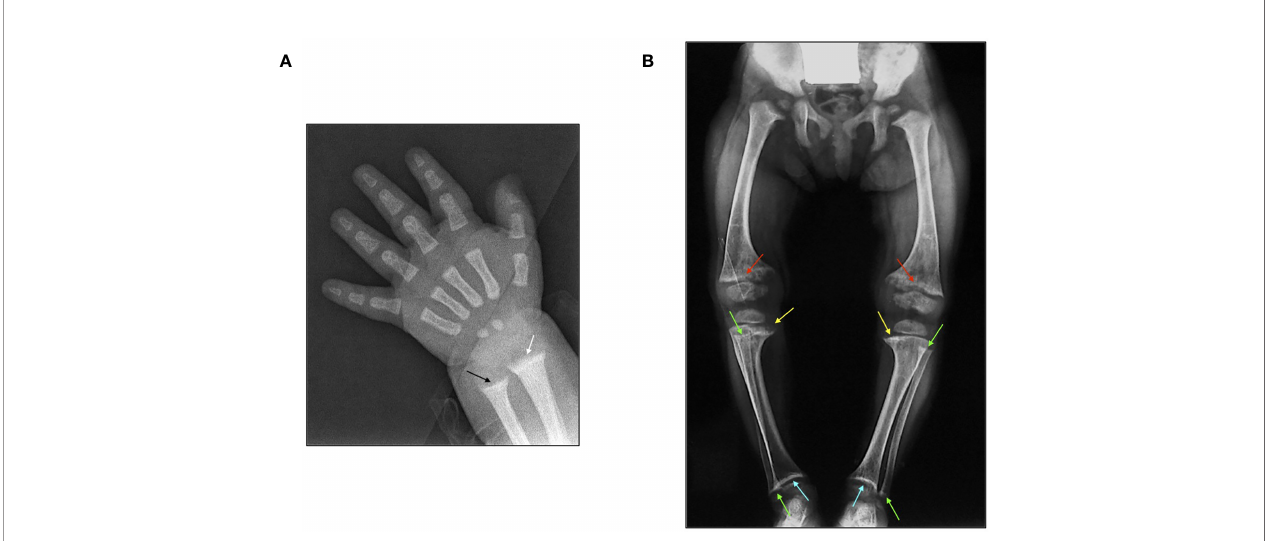
FIGURE 3 | (A) X-ray features of the wrist in a 3-month-old male patient affected by XLH at diagnosis: widening and fraying of the epiphyseal plate (white arrow) and metaphyseal concavity of the ulna (black arrow). (B) X-ray features of the lower limbs in a 2.5-year-old female patient with XLH at diagnosis: genu-varum and distal medial femoral and tibial bowing with widening and fraying of the distal epiphyseal plate of the femur (red arrow) and the proximal medial epiphyseal plate of the tibia (yellow arrow). Metaphyseal concavity of the proximal and distal fi bula (green arrow) and metaphyseal concavity of the distal epiphyseal plate of the tibia (light blue